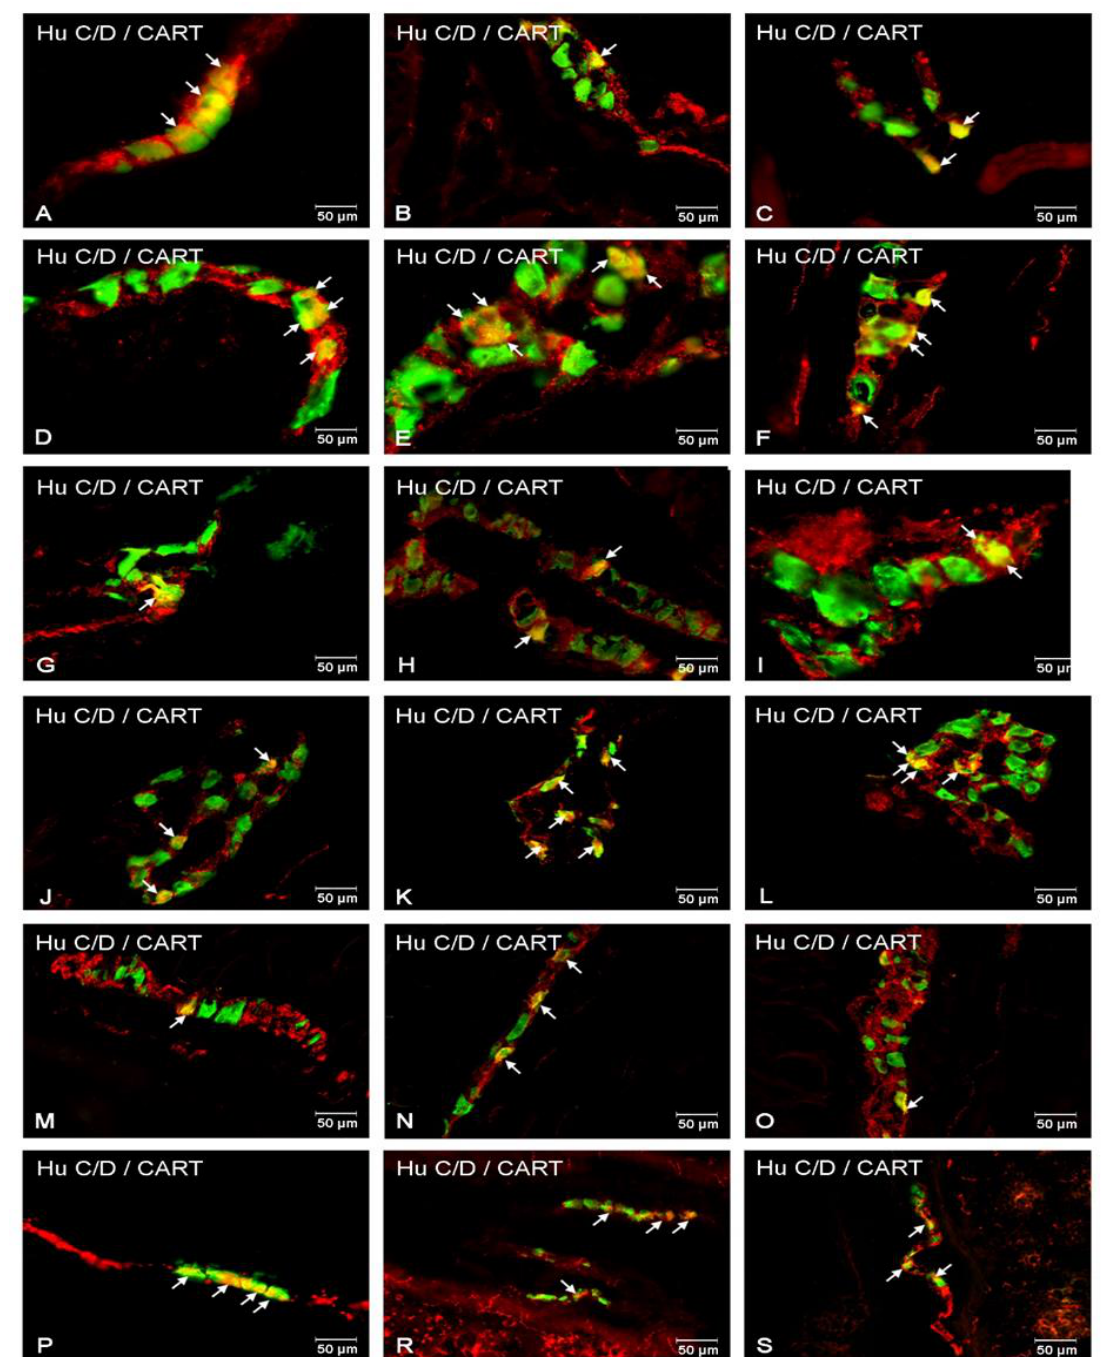
Figure 2. Immunofluorescent staining presenting CART immunoreactivity in cell bodies in the particular intramural plexuses in the small intestine in both control and experimental groups. All photographs have been created by the digital superimposition of two color channels; Hu C/D-positive—used here as a pan-neuronal marker (green), and CART-positive (red). The arrow shows perikaryon containing both examined substances. Myenteric plexus of the duodenum ( A,D ), jejunum ( B,E ), and ileum ( C,F ) under physiological condition ( A–C ) and after streptozotocin administration ( D–F ). Outer submucosal plexus of the duodenum ( G,J ), jejunum ( H,K ), and ileum ( I,L ) under physiological condition ( G–I ) and after streptozotocin administration ( J–L ). Inner submucosal plexus of the duodenum ( M,P ), jejunum ( N,R ), and ileum ( O,S ) under physiological condition ( M–O ) and after streptozotocin administration ( P–S ).